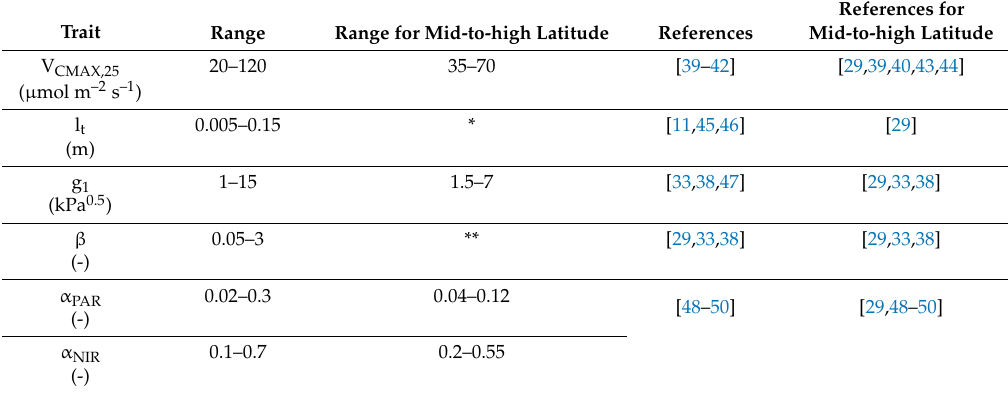
Table 1. Summary of the traits considered in the General Sensitivity Analysis (GSA), their ranges of variation emerging from the literature globally and for mid-to-high latitudes and corresponding supporting